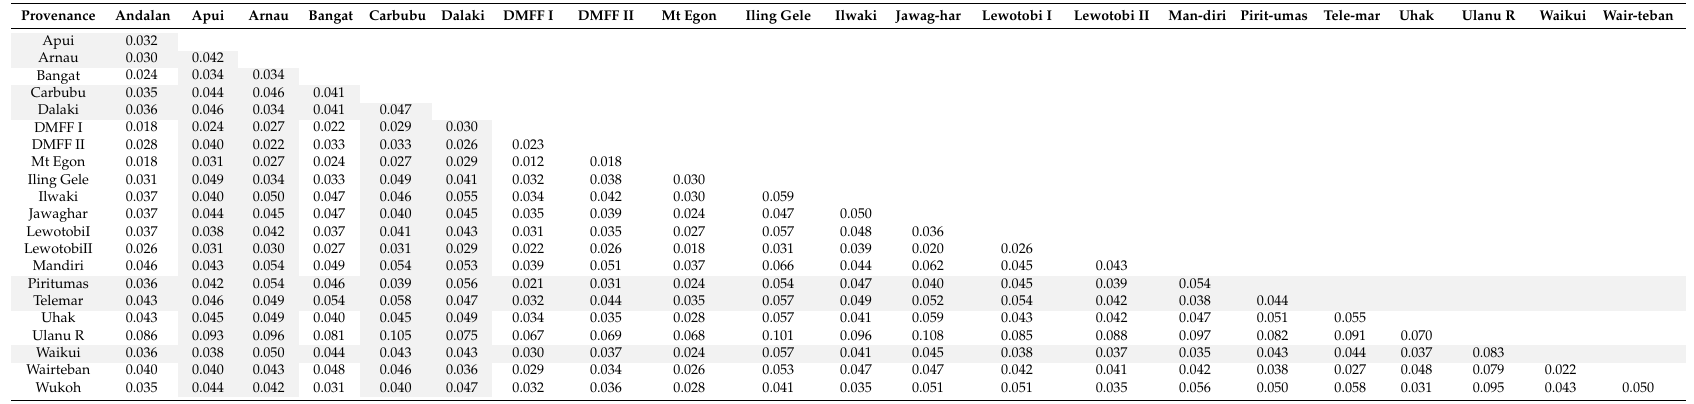
Table 7. Pairwise genetic differentiation indices (F st ) for the provenances comprising the first cycle breeding population of E. urophylla —grey